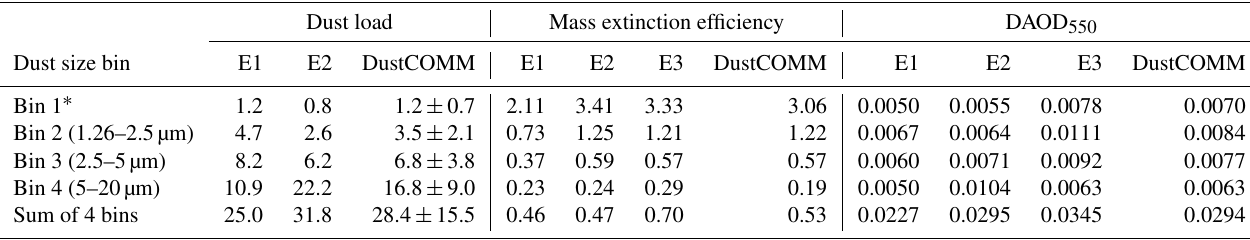
Table 3. Annual averages of dust load (Tg), mass extinction efficiency (m 2 g − 1 ), and DAOD 550 at each bin on a global scale. The size- resolved dust concentration and shape in IMPACT-Sphere-Mineral-V83 (E1) simulation was adjusted to DustCOMM in DustCOMM- Asphere-DB19-V83 (E2) simulation. At the same time, we maintained the consideration of asphericity on the gravitational velocity and kept the dust concentrations unaltered between IMPACT-Sphere-Mineral-V83 (E1) and IMPACT-Asphere-DB19-DB17 simulations (E3). Dust load Mass extinction efficiency DAOD 550 Dust size bin E1 E2 DustCOMM